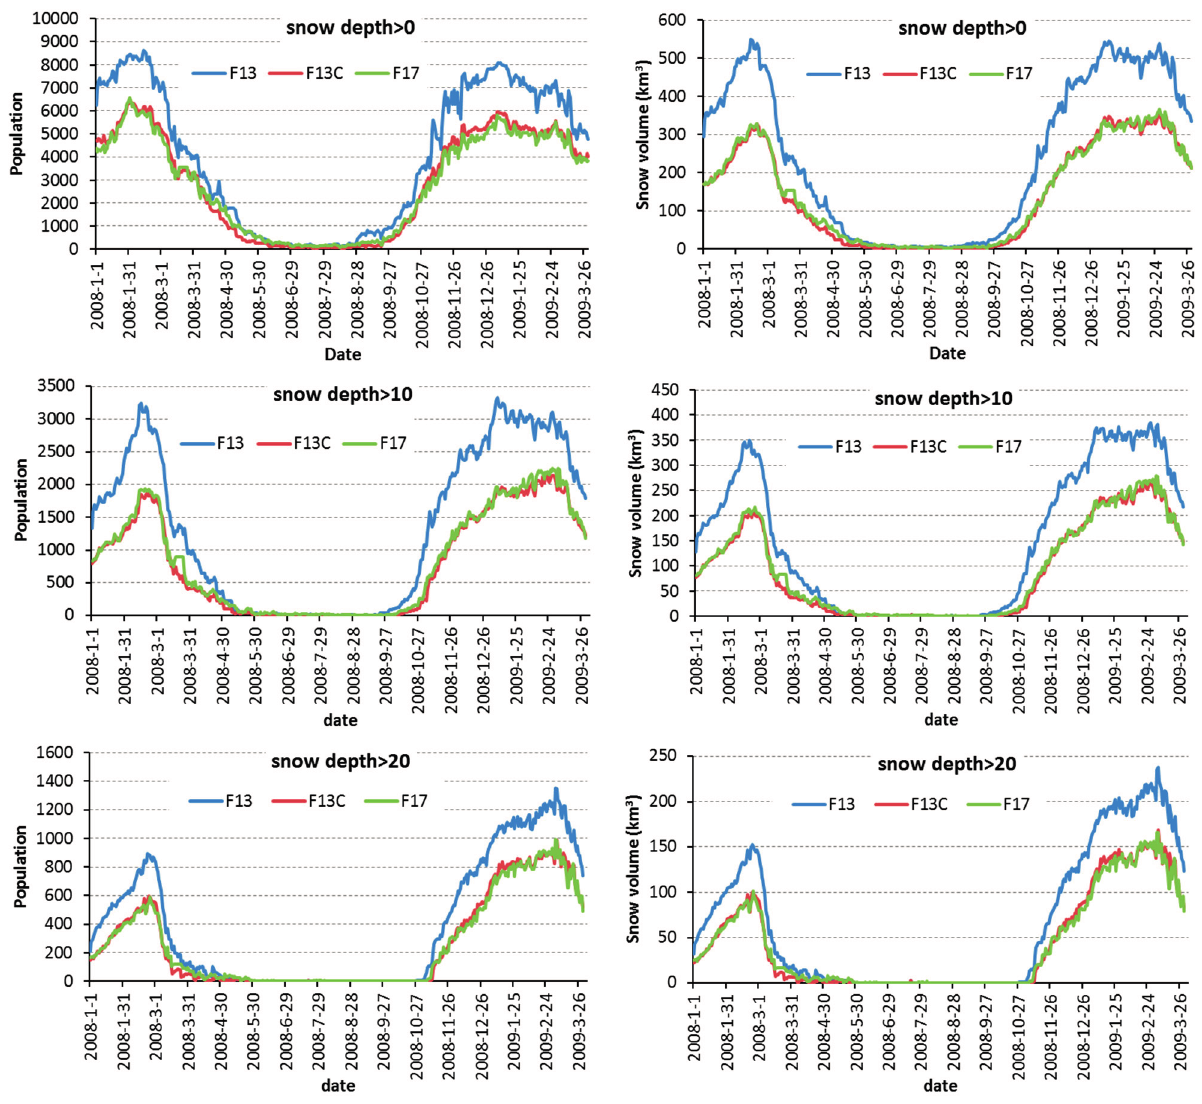
Figure 3. Comparison of the populations of snow-covered pixels and the corresponding snow volume at different ranges of snow depths (snow depth > 0, snow depth > 10 and snow depth > 20) derived from F13, F13C and